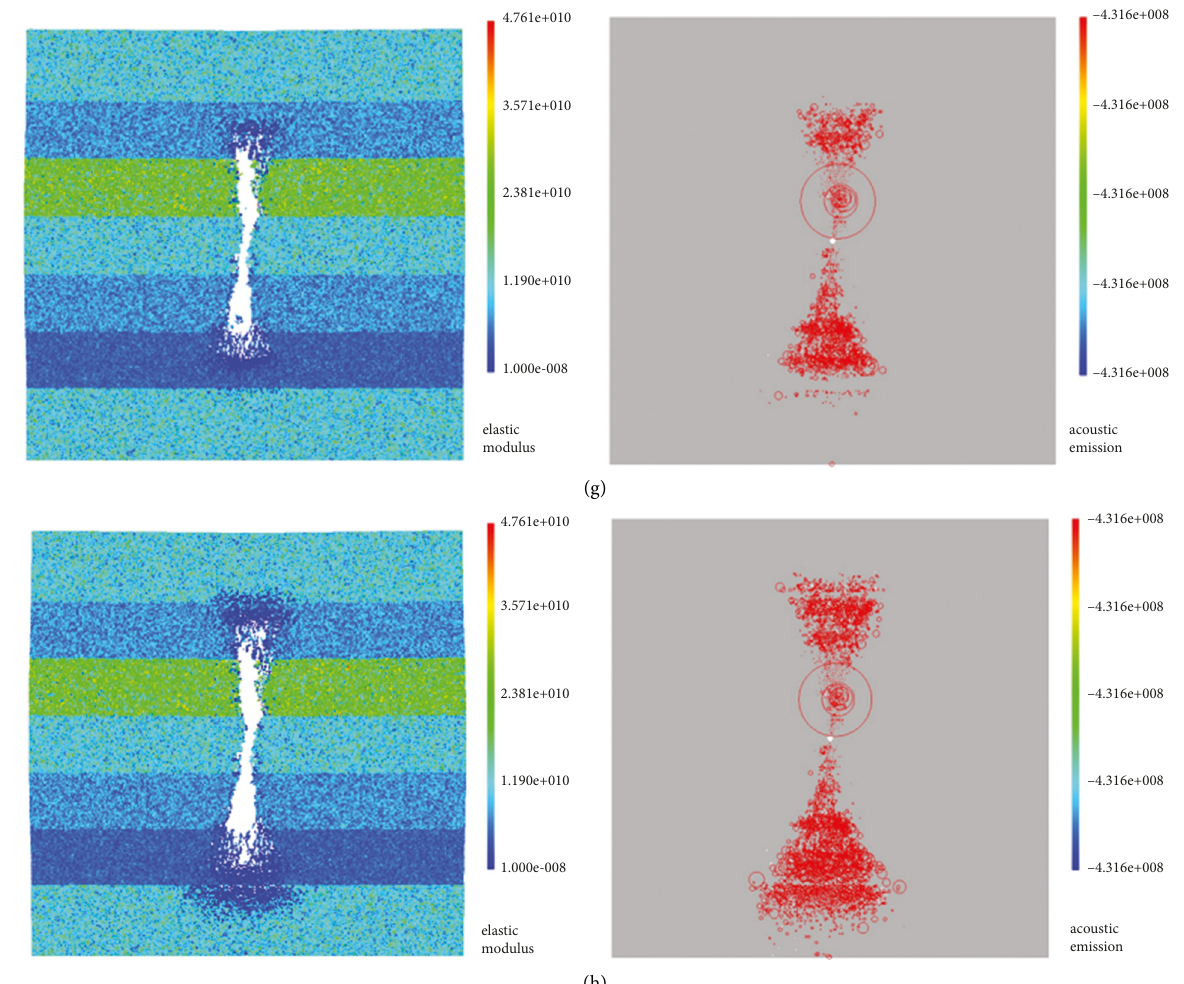
Figure 8: Elastic modulus and acoustic emission of numerical model No. 2. (a) Step 86–1. (b) Step 87–2. (c) Step 87–3. (d) Step 88–7. (e) Step 88–9. (f) Step 88–10. (g) Step 88–13. (h) Step